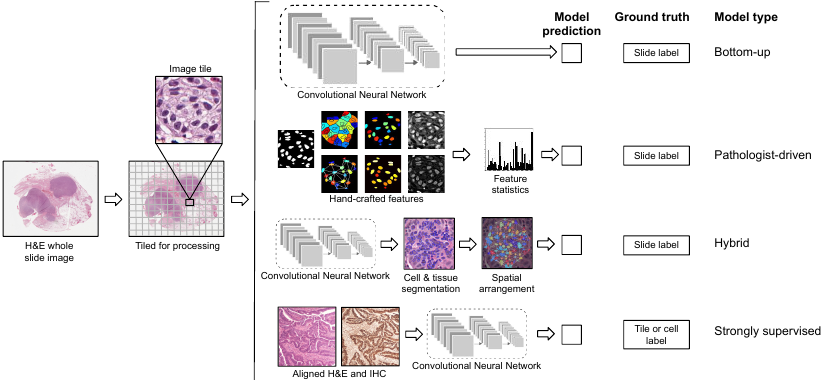
Figure 1. Workflow and general frameworks for predicting molecular biomarkers from H&E: (1) bottom-up methods that learn patterns directly from the images, (2) pathologist-driven features, (3) hybrid workflows, (4) strongly supervised